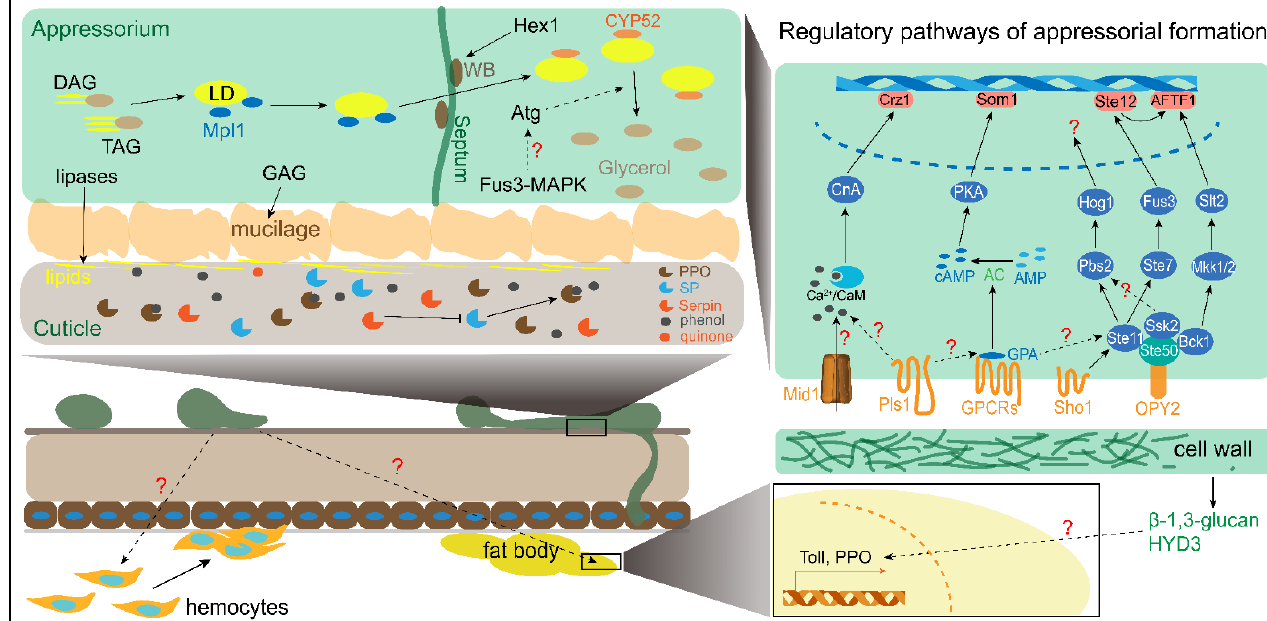
Figure 2. A schematic model of the early phase interaction between Metarhizium spp. and locusts. The regulatory mechanisms of appressorial formation and the early phase immune response are depicted. The regulatory pathway of appressorial formation only represents the main signaling pathway, including Ca 2+ /CaM, cAMP/PKA, and MAPKs. The processes of LD synthesis and degradation are also shown in the model. The dotted arrows represent indirect actions to promote another component. The solid arrows or T indicate direct promotion or restraint to another component. DAG, diacylglycerol; TAG, triacylglycerol; LD, lipid droplet; GAG, galactosaminogalactan and the biosynthesis genes cluster; WB, woronin body; SP, serine protease; PPO, prophenoloxidase.